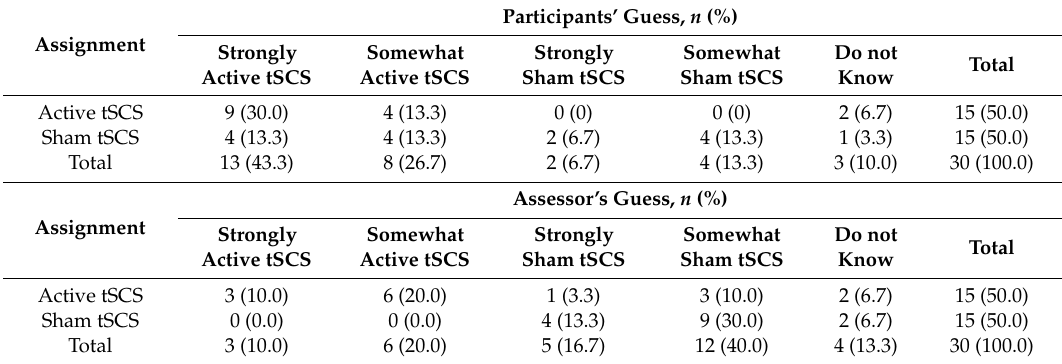
Table 4. Assessment of the blinding. Absolutes values and percentages of answers selected by participants and